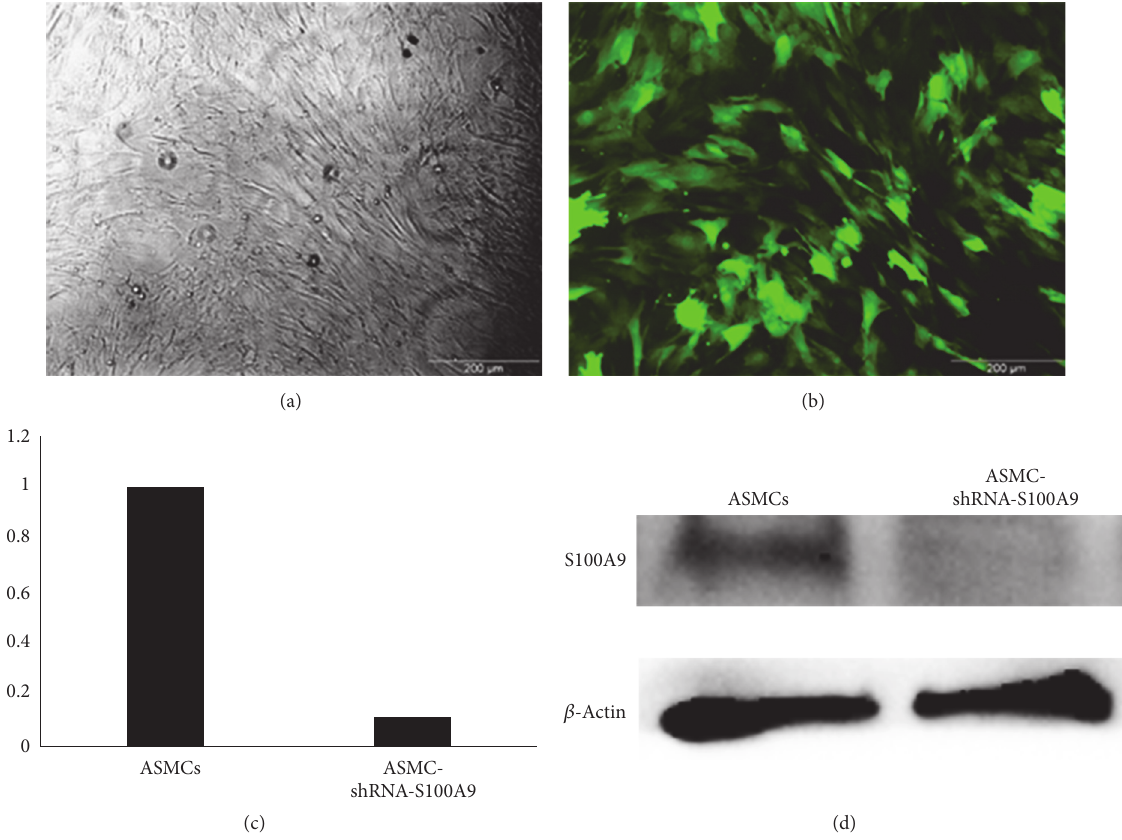
Figure 1: Generation of airway smooth muscle cells (ASMCs) with stable knockdown of S100A9 expression (ASMC-shRNA-S100A9). (a) Light microscopy image of ASMC-shRNA-S100A9 cells. (b) Green fluorescent protein (GFP) expression indicated the expression of S100A9 RNAi, and GFP-positive cells accounted for more than 95% of the total cell population by fluorescence microscopy. (c) Ratio of S100A9 mRNA expression in ASMC-shRNA-S100A9 cells compared with control ASMCs. (d) Western blots showed that S100A9 protein expression was significantly decreased in ASMC-shRNA-S100A9 cells.